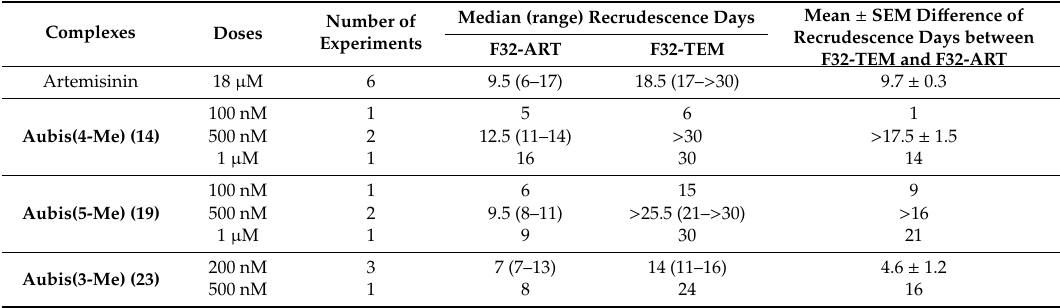
Table 2. Recrudescence capacity of Plasmodium falciparum F32-ART and F32-TEM strains after 48h-drug